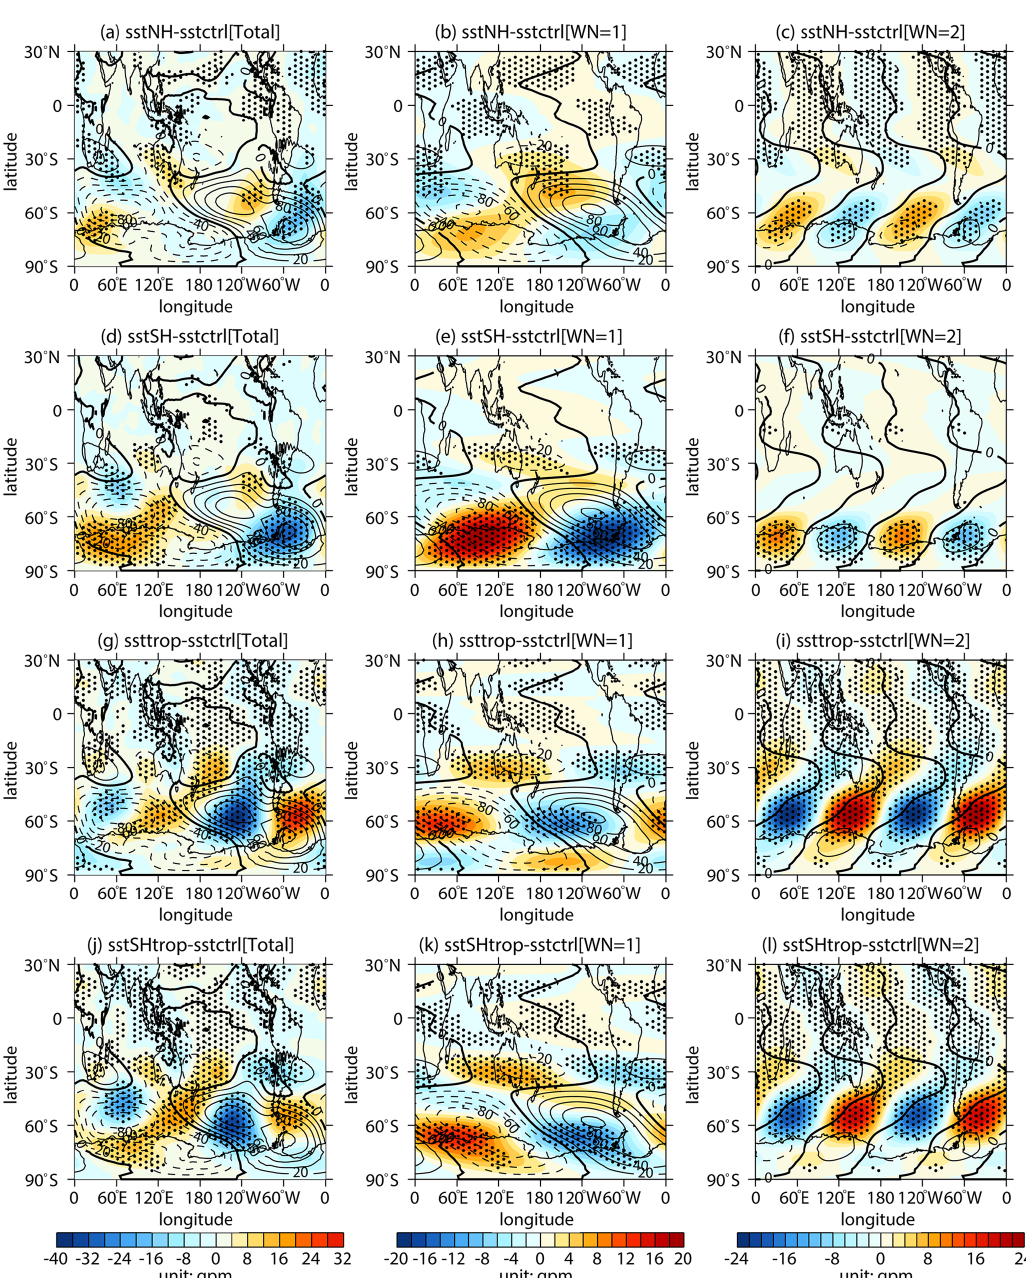
Figure 12. Differences (shading) in the (a, d, g, j) 500hPa geopotential height zonal deviations with their (b, e, h, k) wave 1 component and (c, f, i, l) wave 2 component between sensitivity experiments ( a, b, c sstNH; d, e, f sstSH; g, h, i ssttrop; j, k, l sstSHtrop) and the control experiment (sstctrl). The mean distributions (contours with an interval of 20gpm; positive and negative values are depicted by solid and dashed lines, respectively; zeroes are depicted by thick solid lines) of them are derived from the control experiment. The stippled regions represent the mean difference significant at/above the 90% confidence